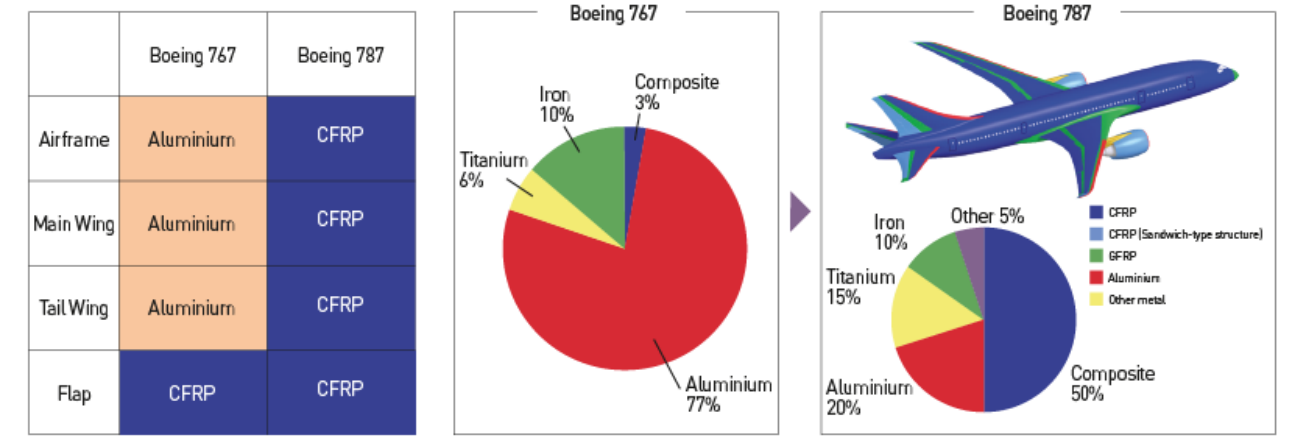
Figure 12. A comparison between the Boeing 767 and the Boeing 787 in using CFRP (reprinted with permission from Ref. [49]).